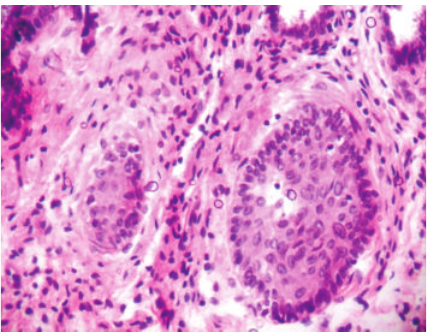
Figure 3: High power photomicrograph ( × 400) showing islands of odontogenic rests.